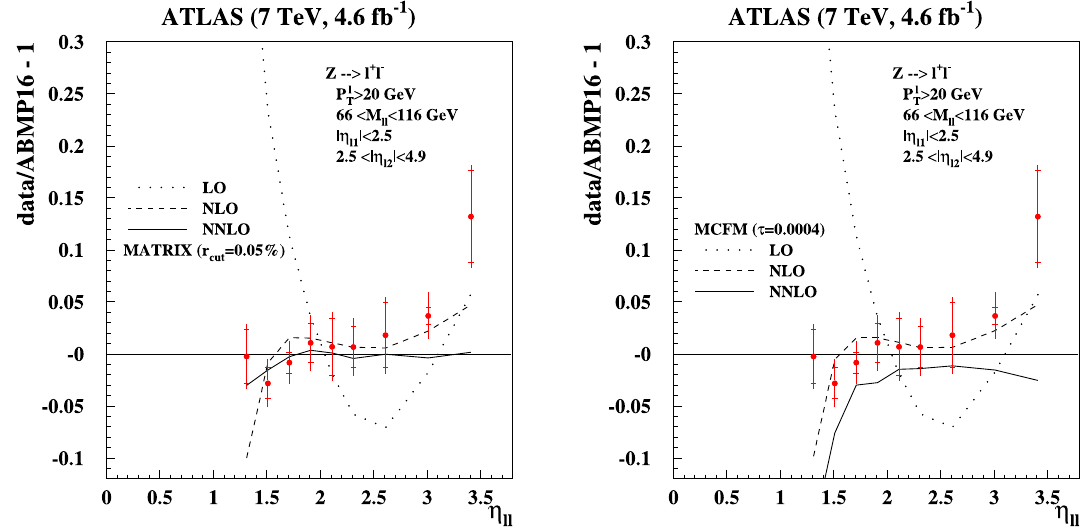
Fig. 10 Same as Fig. 9 using predictions by the MATRIX (left) and the MCFM codes